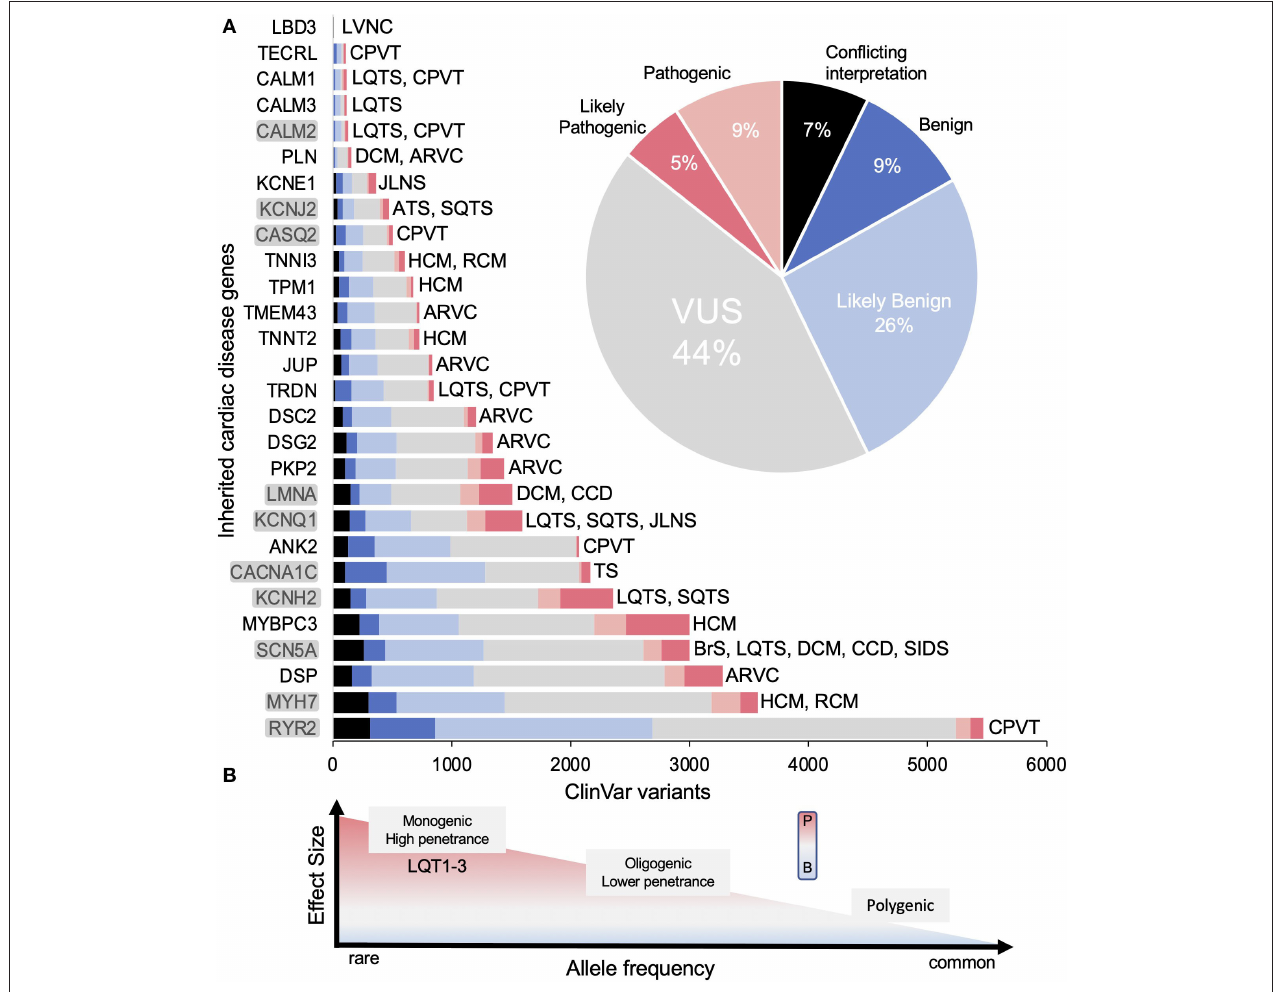
FIGURE 2 | Genes associated with inherited cardiac arrhythmias. (A) The total number of variants for each gene in ClinVar and their classifications [conflicting interpretation (CI), likely benign (LB), benign (B), variant of uncertain significance (VUS), likely pathogenic (LP) and pathogenic (P)] as of June 2022. Inset shows relative percentages for all genes combined. Disease associations are not comprehensive (e.g., LMNA is linked to many non-cardiac diseases). Genes reviewed here shaded gray. (B) Graph illustrating the range of effects variants can have toward pathogenicity. Figure adapted from Ingles et al. (8). Disease abbreviations: CPVT, catecholaminergic polymorphic ventricular tachycardia; HCM, hypertrophic cardiomyopathy; RCM, restrictive cardiomyopathy; ARVC, arrhythmogenic ventricular cardiomyopathy; BrS, Brugada syndrome; LQTS, long QT syndrome; DCM, dilated cardiomyopathy; CCD, cardiac conduction disease; SIDS, sudden infant death syndrome; SQTS, short QT syndrome; TS, Timothy syndrome; JLNS, Jeverell and Lange-Nielsen syndrome; ATS, Andersen-Tawil syndrome; LVNC, left ventricular non-compaction